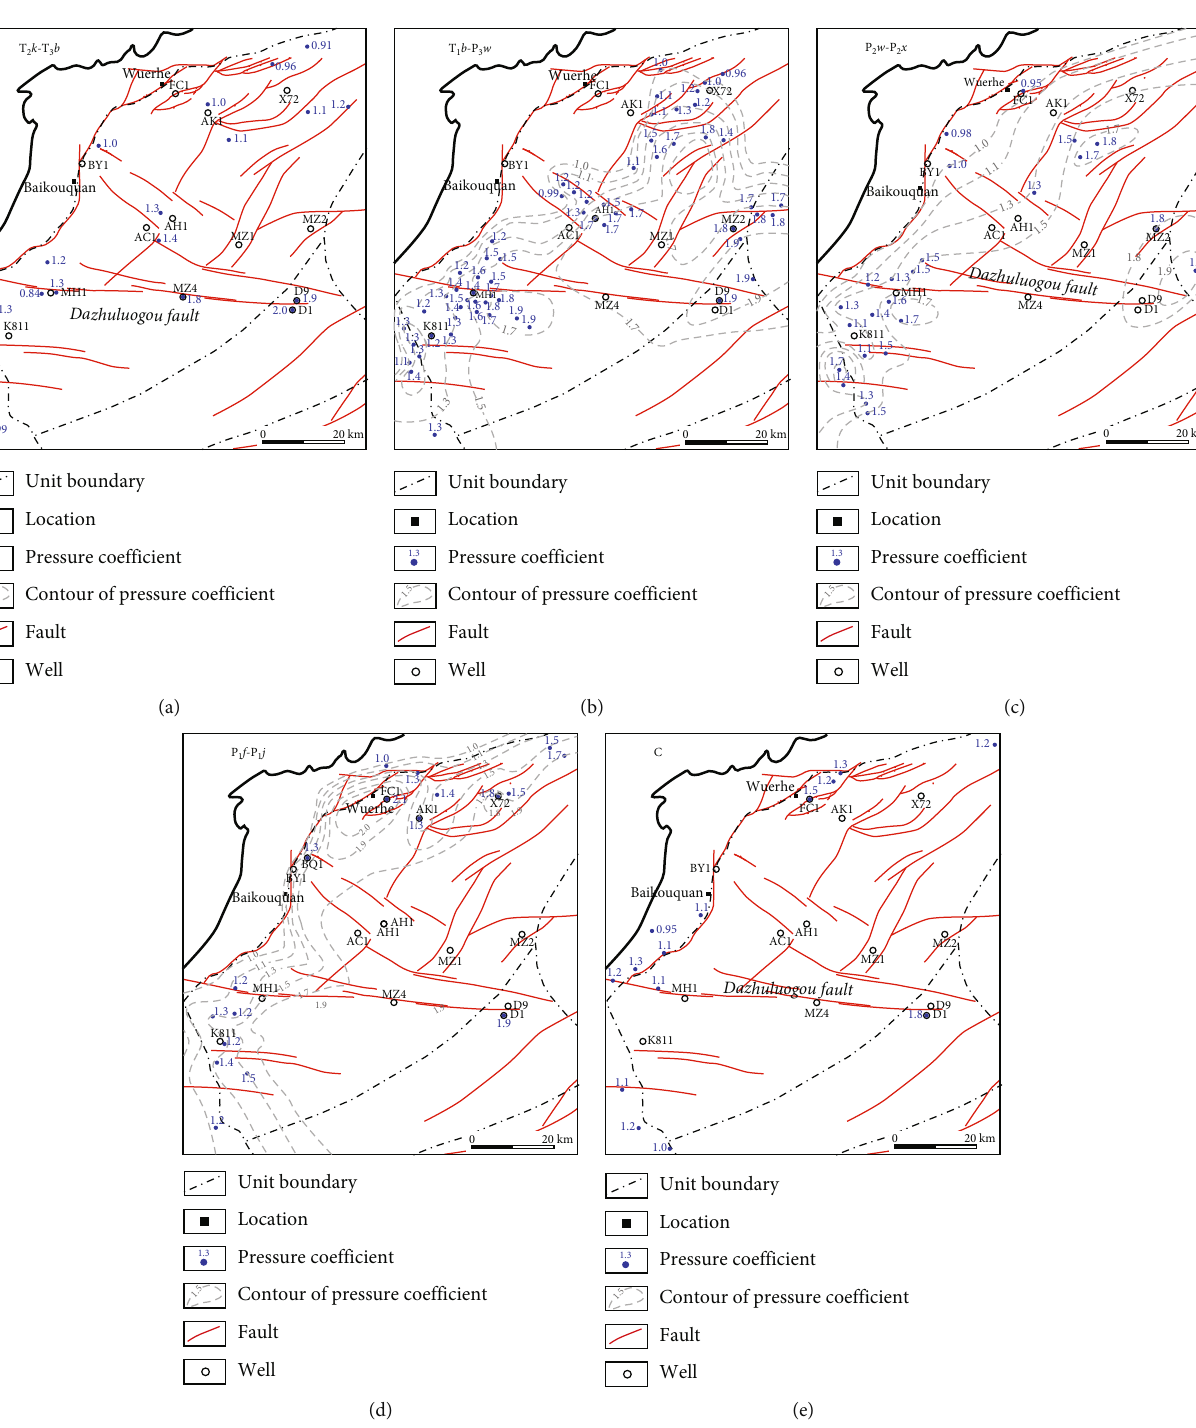
Figure 5: Planar distribution of reservoir overpressure in the (a) Baijiantan-Karamay Formation, (b) Baikouquan-Upper Wuerhe Formation, (c) Lower Wuerhe-Xiazijie Formation, (d) Fengcheng-Jiamuhe Formation, and (d) upper Carboniferous. (Note: considering the uneven distribution of data and limited distribution of overpressure in Baijiantan-Karamay Formation and upper Carboniferous, no contours are shown